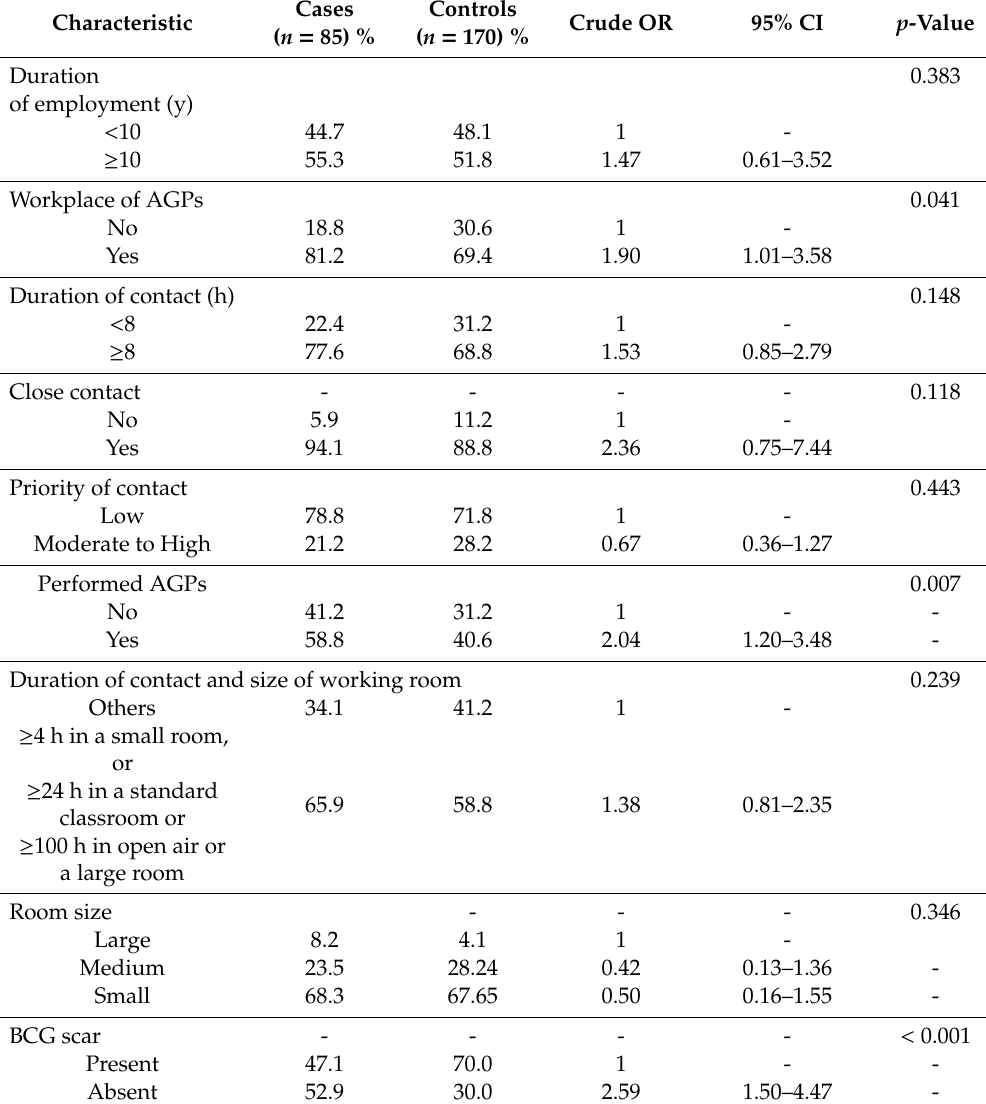
Table 3. Crude odds ratios for LTBI associations with various risk